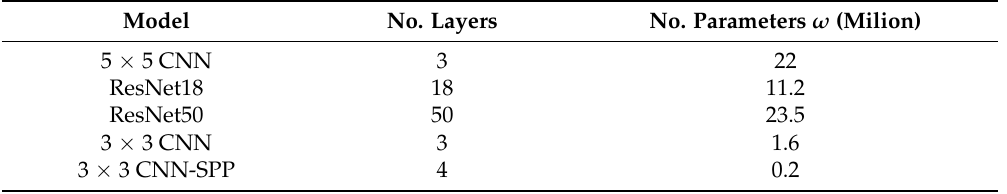
Table 2. The complexity of the proposed models using chest X-ray images.